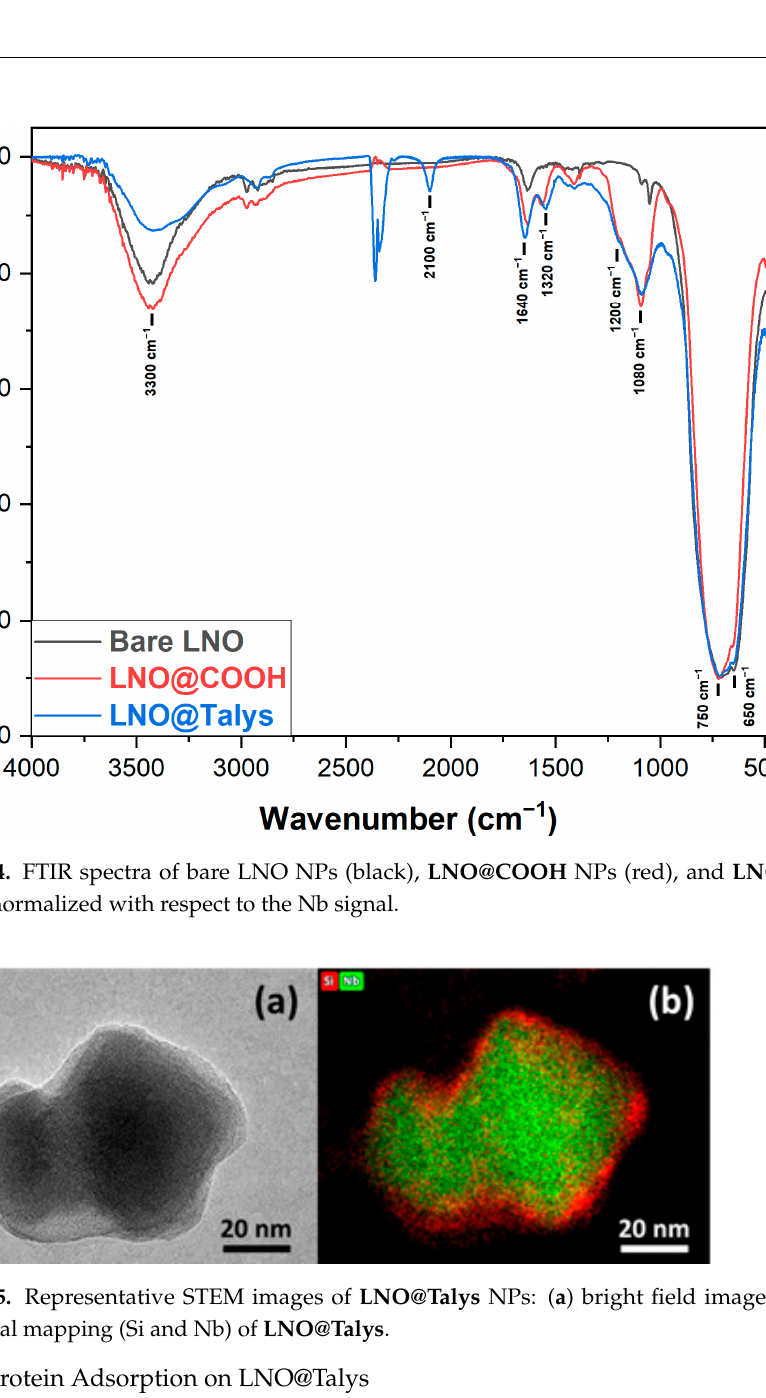
Figure 5. Representative STEM images of LNO@Talys NPs: ( a ) bright field image and ( b ) EDX ele- mental mapping (Si and Nb) of LNO@Talys .